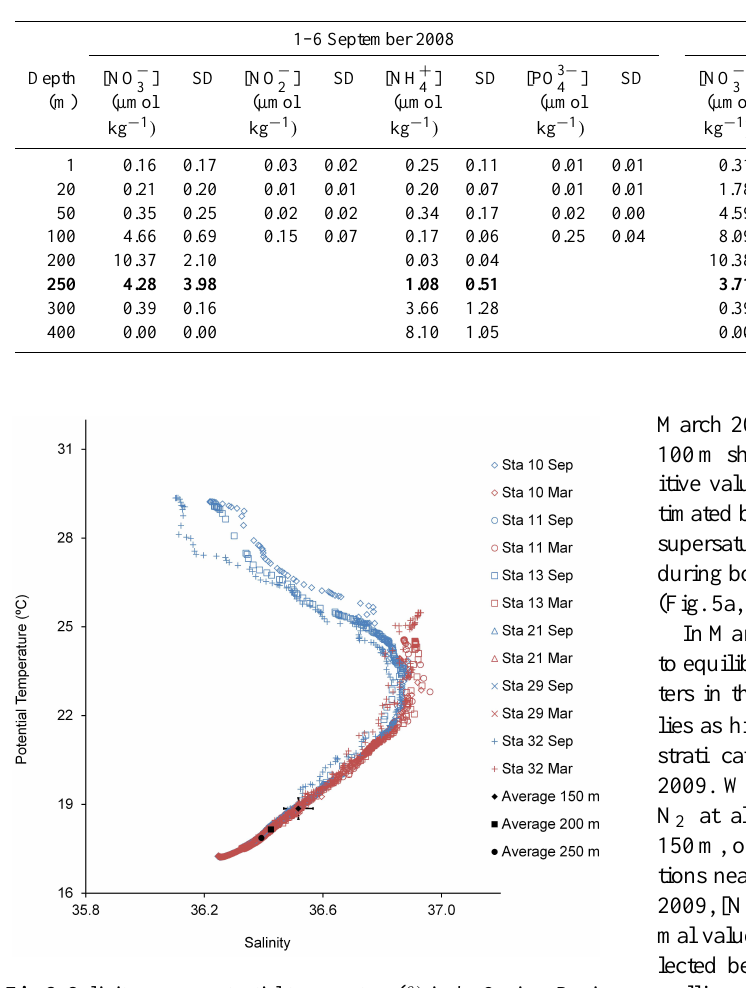
Fig. 3. Salinity versus potential temperature ( θ) in the Cariaco Basin at stations sampled for N xs measurements during September 2008 2 and March 2009. Black symbols represent the average potential temperature and salinity from all six stations and sampling periods at 150 (diamond), 200 (square) and 250 (circle)